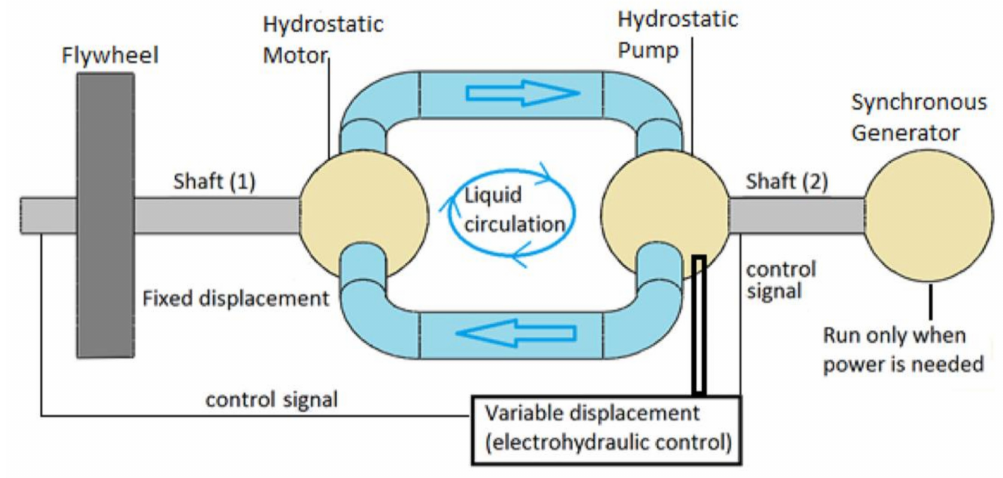
Figure 1. An illustration of a typical FESS, reproduced with permission from Elsevier [29]. One typical use for FESS is to smooth the varying supply of electricity from either a change in the grid supply or renewable systems. Renewable energy generation systems are generally intermittent in their creation and supply of electricity. Flywheels are capable of rectifying the wind oscillations, coupled with improvement in the system frequency, and for solar systems, they can be combined with batteries to enhance the system output as well as extend the battery’s operational lifetime. This allows flexibility and control to rely more on renewable sources [31,35]. The flywheel energy storage system (FESS) is one such storage system that is gaining popularity. This is due to the increasing manufacturing capabilities and the growing variety of materials available for use in FESS construction.